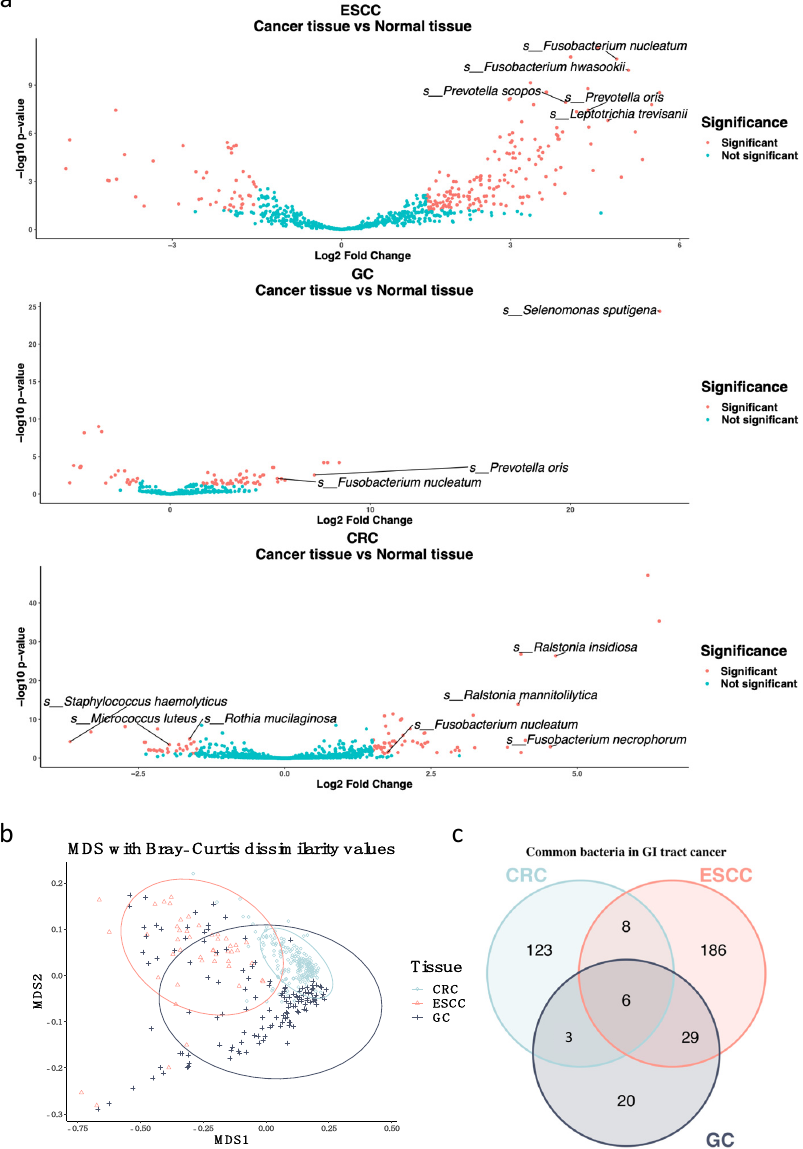
Figure 2. Microbiome differential abundance analysis of GI tract cancer WTS data. ( a ) Volcano plot demonstrating the differential prevalence of the microbiome between cancer and normal tissues from the esophageal (GSE130078), gastric (GSE180440), and colorectal (GSE113255) samples. The microbiome was colored when it surpassed the significance threshold ( p -value < 0.05, fold change > 1.5). Names of species levels in the microbiome are annotated. ( b ) Principal coordinate analysis (PCoA) plot on the Bray − Curtis dissimilarity indexes between microbiome profiles of different can- cer types. ( c ) Venn Diagram showing numbers of overlapping microbiomes between GI tract cancer types.